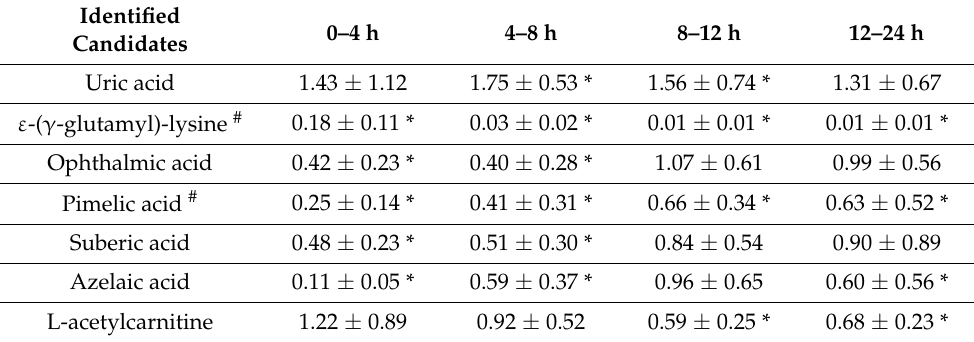
Table 3. The mean fold-changes for eight metabolites in the urine sample after 90 mg DA-9701 single administration at fasting